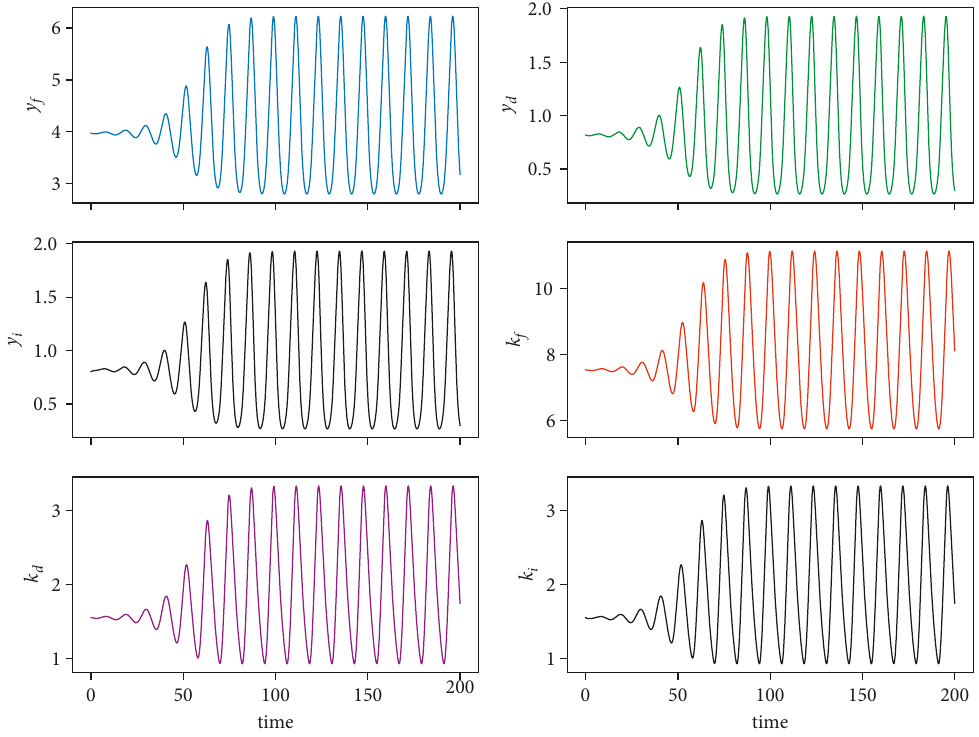
Figure 1: The plots of the trajectories for y